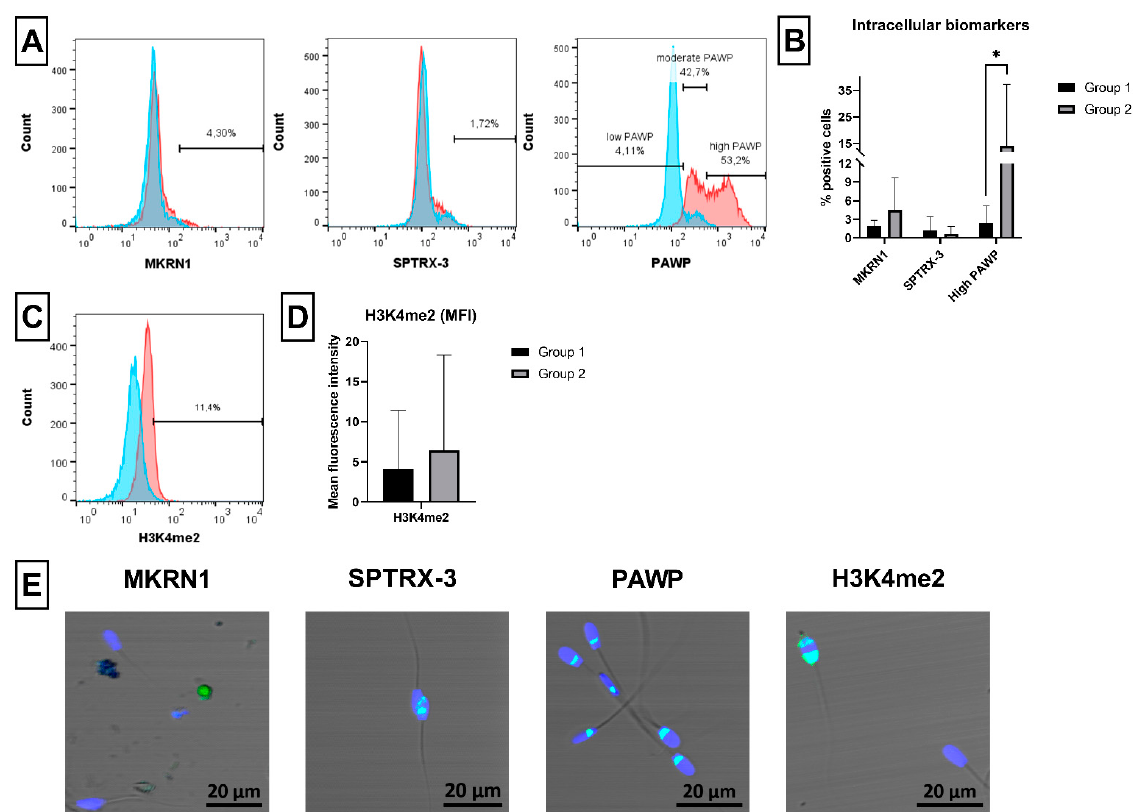
Figure 8. Evaluation of defective spermatozoa with overexpression of MKRN1, SPTRX-3, PAWP and H3K4me2. Illustrative flow-cytometric histograms showing evaluation strategy of analyzed fluorescent markers. Spermatozoa gated using FSC/SSC dot plot were showed using histogram in green FL1 channel (MKRN1, SPTRX-3 and PAWP), where a control unstained population (blue) was compared to positively stained population (red) according to fluorescent signals. Two positive pop- ulations (moderate and high) can be distinguished for PAWP according to the fluorescent intensity ( A ). Graph showing comparison of defective spermatozoa positive for MKRN1 and SPTRX-3 or highly positive for PAWP (high PAWP) in Group 1 and Group 2 ( B ). Illustrative flow-cytometric histogram showing analyzed fluorescent marker. Spermatozoa gated using FSC/SSC dot plot were showed using histogram in green FL1 channel (H3K4me2), where a control unstained population is in blue color and positively stained population is in red color ( C ). Graph showing comparison of defective spermatozoa positive for H3K4me2 in Group 1 and Group 2. The final value for mean fluorescence intensity (MFI) of H3K4me2 was obtained after subtracting the MFI of control sample stained only with secondary antibody from the signal (MFI) of the experimental sample ( D ). Illustrative images from confocal microscopy (Zeiss LSM 700; magnification at 200 × , scale bar = 20 µ m) showing the staining of ram semen samples by different antibodies (green) and DAPI (blue: nucleus) ( E ). Group 1—semen samples with sperm viability over 60%, Group 2—semen samples with sperm viability under 60%. The data are expressed as the means ± SD; difference is statistically significant at * p <